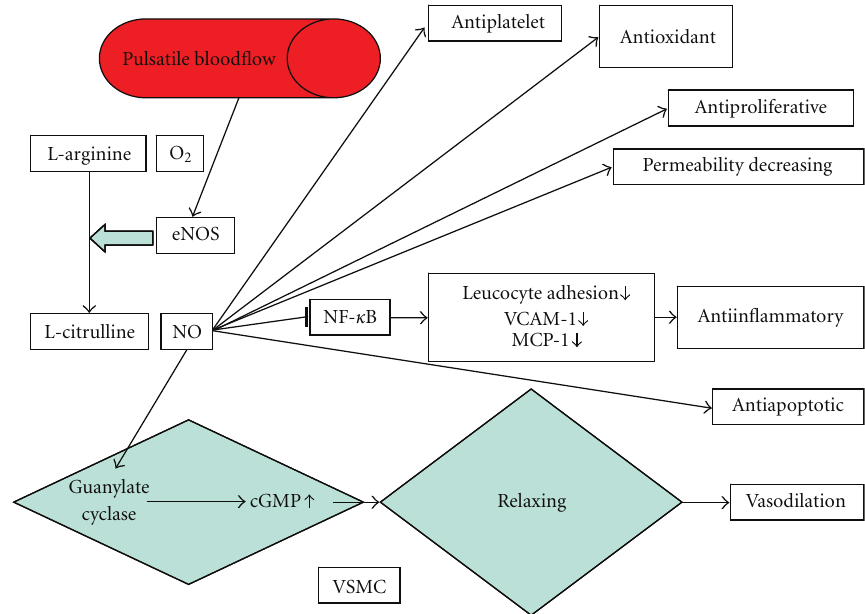
Figure 1: Properties and production process of NO (nitric oxide) as important factor in endothelial